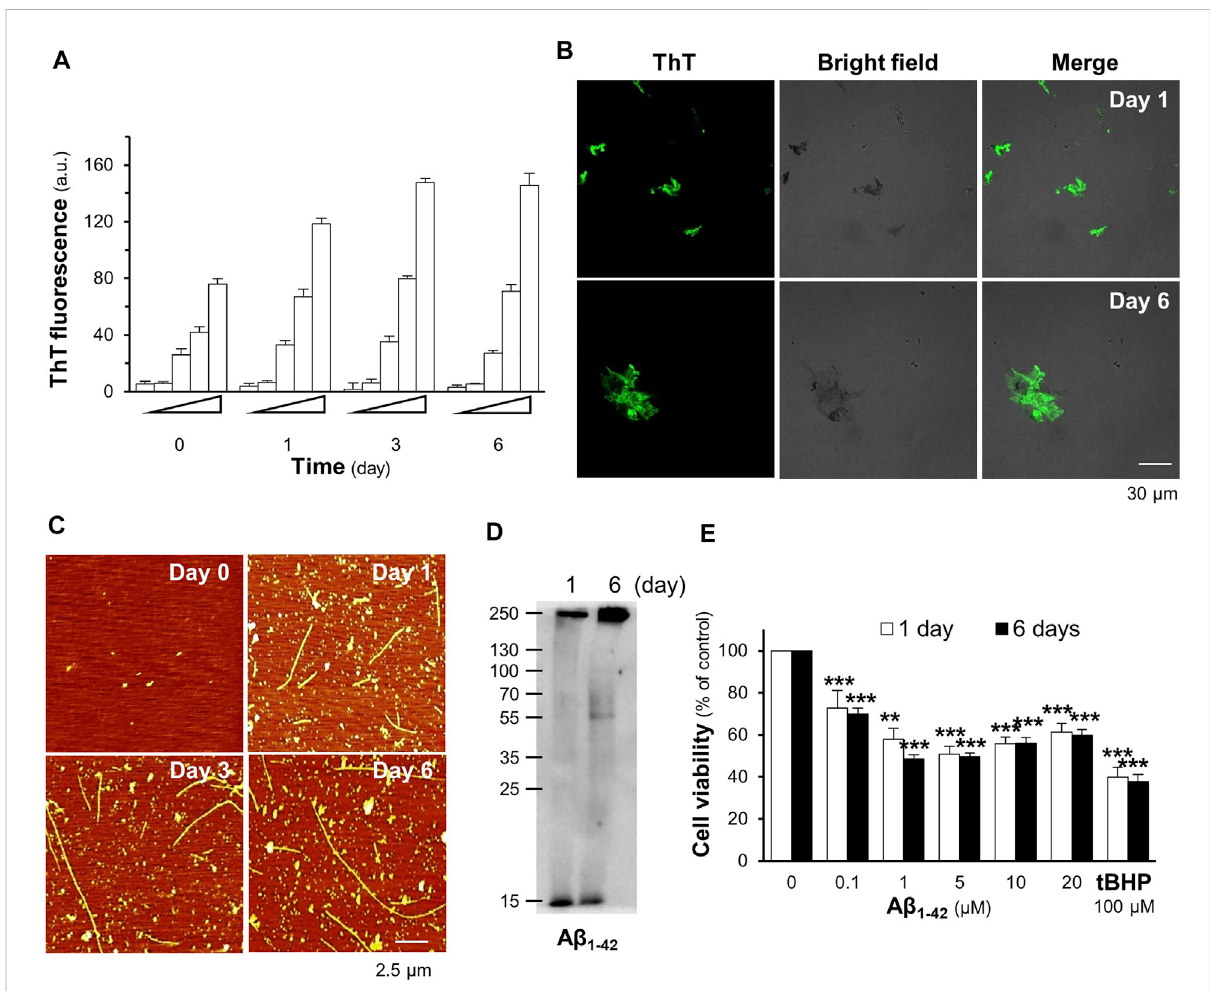
FIGURE 2 A β 1-42 fi brilsinducecelldeathinPC12cells. (A) TheaggregationoftheA β 1-42 monomer(0.1 – 20 μ M)incubatedat37 ° Cfor0,1,3,and6 dayswas analyzed using the ThT fl uorescent assay. (B) The fl uorescence images of ThT-stained A β aggregates (10 μ M) at 1 and 6 days of aging (C) The A β 1-42 monomerat10 μ Magedat37 ° Cfor0,1,3,and6 dayswasmountedfortheAFManalysis.TheformationofA β 1-42 fi brilswasobservedatascansizeof 2.5 μ m. (D) Western blotting of A β 1-42 monomer (approximately 15 kDa) and aggregates ( > 55 kDa). (E) A β 1-42 (0.1 – 20 μ M) aggregates at days 1 and 6 were applied to PC12 cells for 24 h. The MTT assay was used as an indicator of cell viability. Graphs represent the mean ± SEM for n ≥ 4. The signi fi cant difference between untreated and treated cells with A β 1-42 aggregates is represented by *** p <